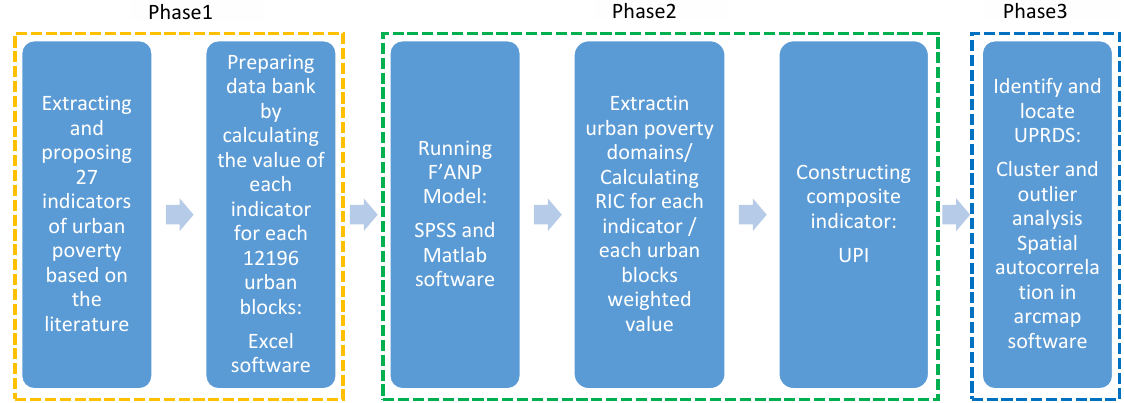
Fig.3: The research methodology and its process